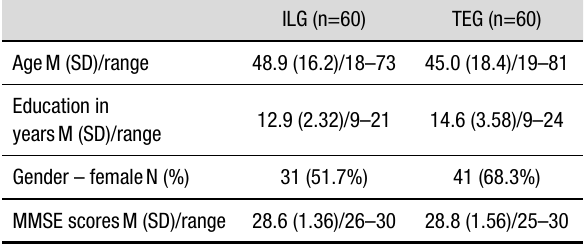
Table 1. Demographic and cognitive data of participants.